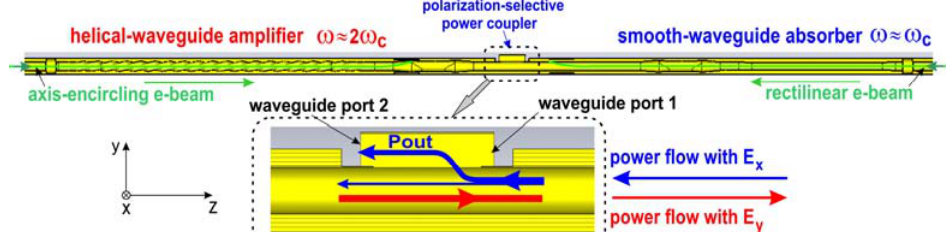
Fig. 1. 3D PIC computer model of an ultrashort pulse oscillator which is based on a helical-waveguide gyro-TWT and a reso- nance cyclotron absorber with a rectilinear electron